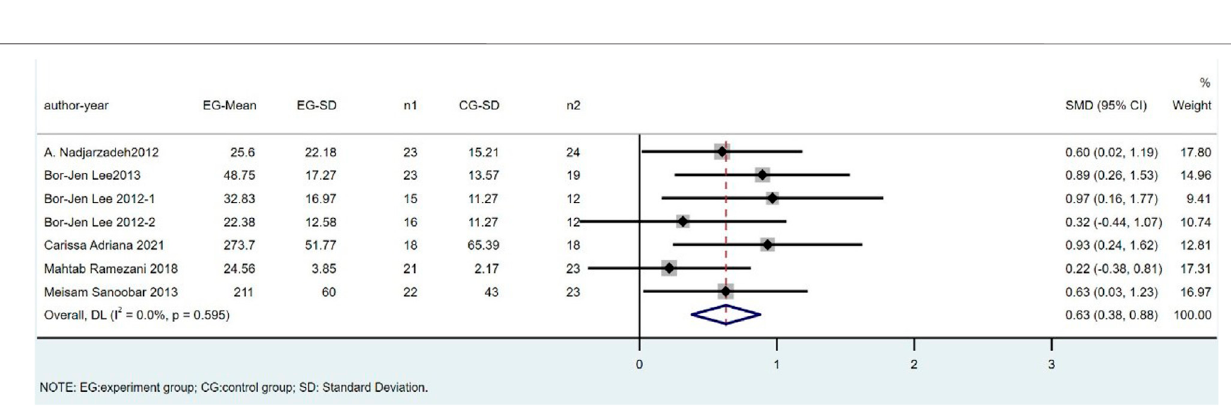
FIGURE 4 | Meta-analysis of studies investigating the effect of CoQ10 supplements use on SOD level.